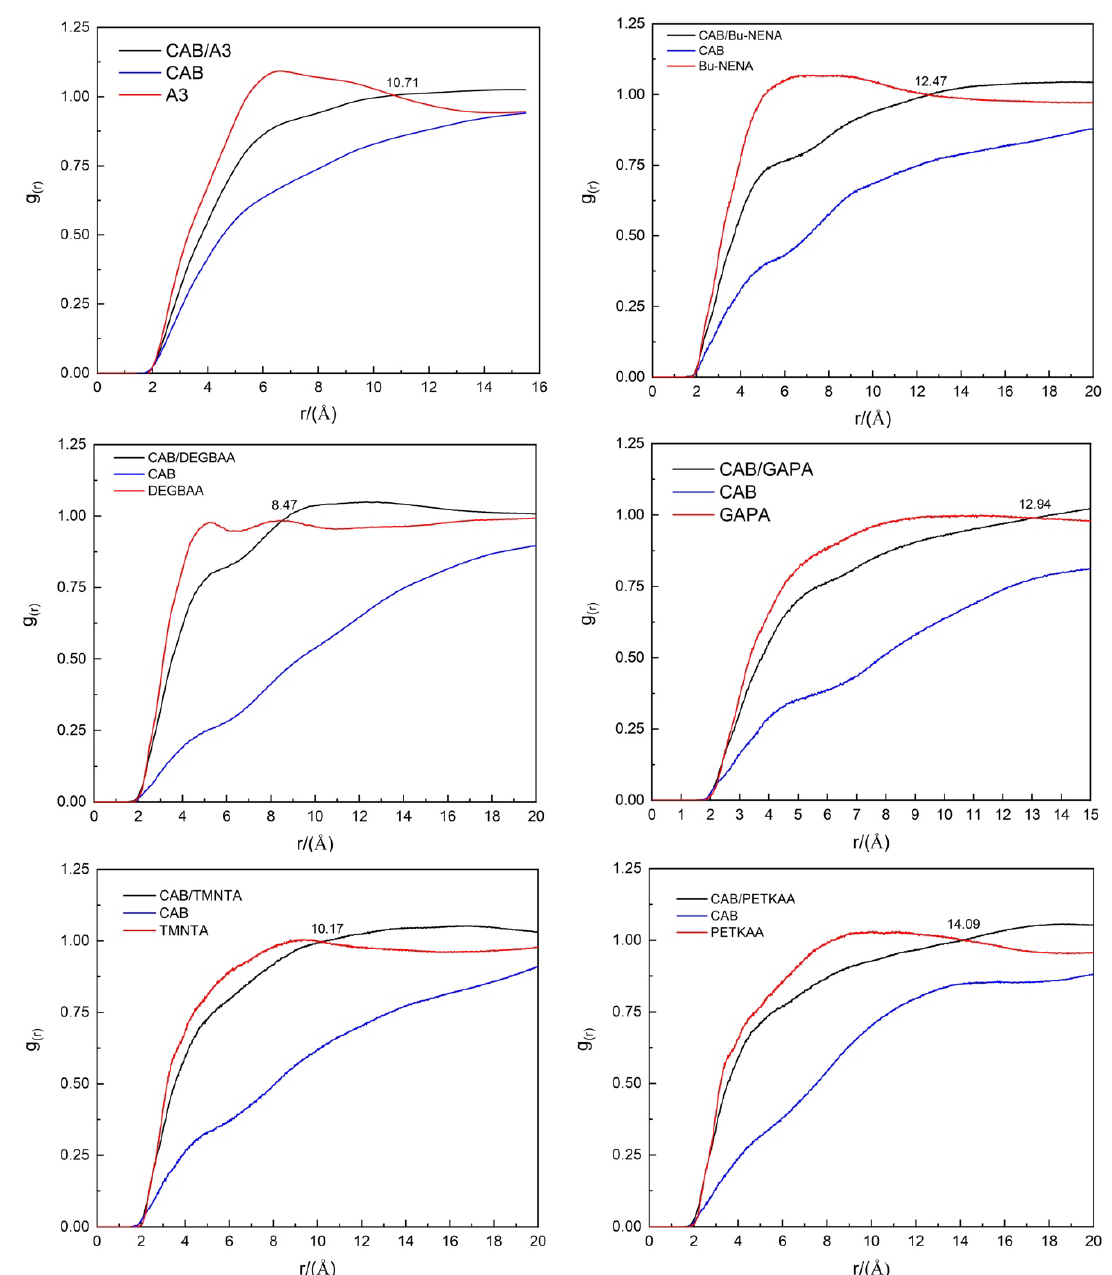
Figure 3. Radial distribution functions (RDF) curves of different CAB/plasticizer systems.